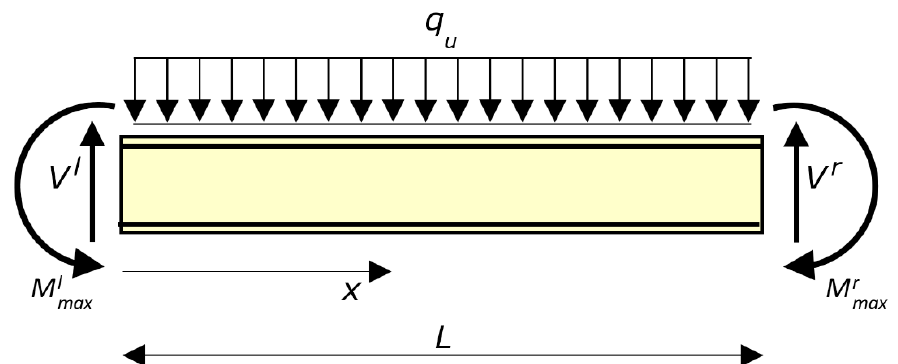
Figure 4. Second step of the method for calculating the ultimate load q u . The bending moments M l max and M r max are the moment capacity of the left end and of the right end, respectively (or of the adjoining structures, if weaker). The shear forces V l and V r result from equilibrium.